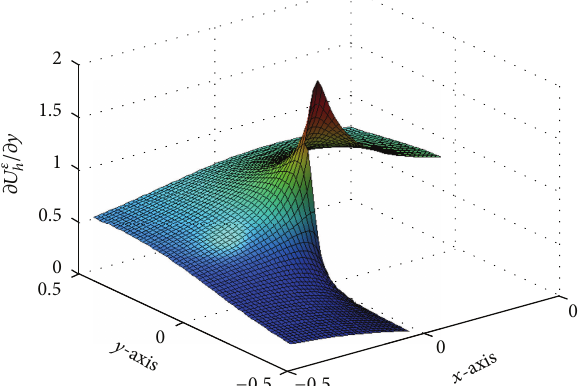
Figure 9: 𝜕𝑈 𝜀 ℎ /𝜕 𝑦 in the “singular” part.